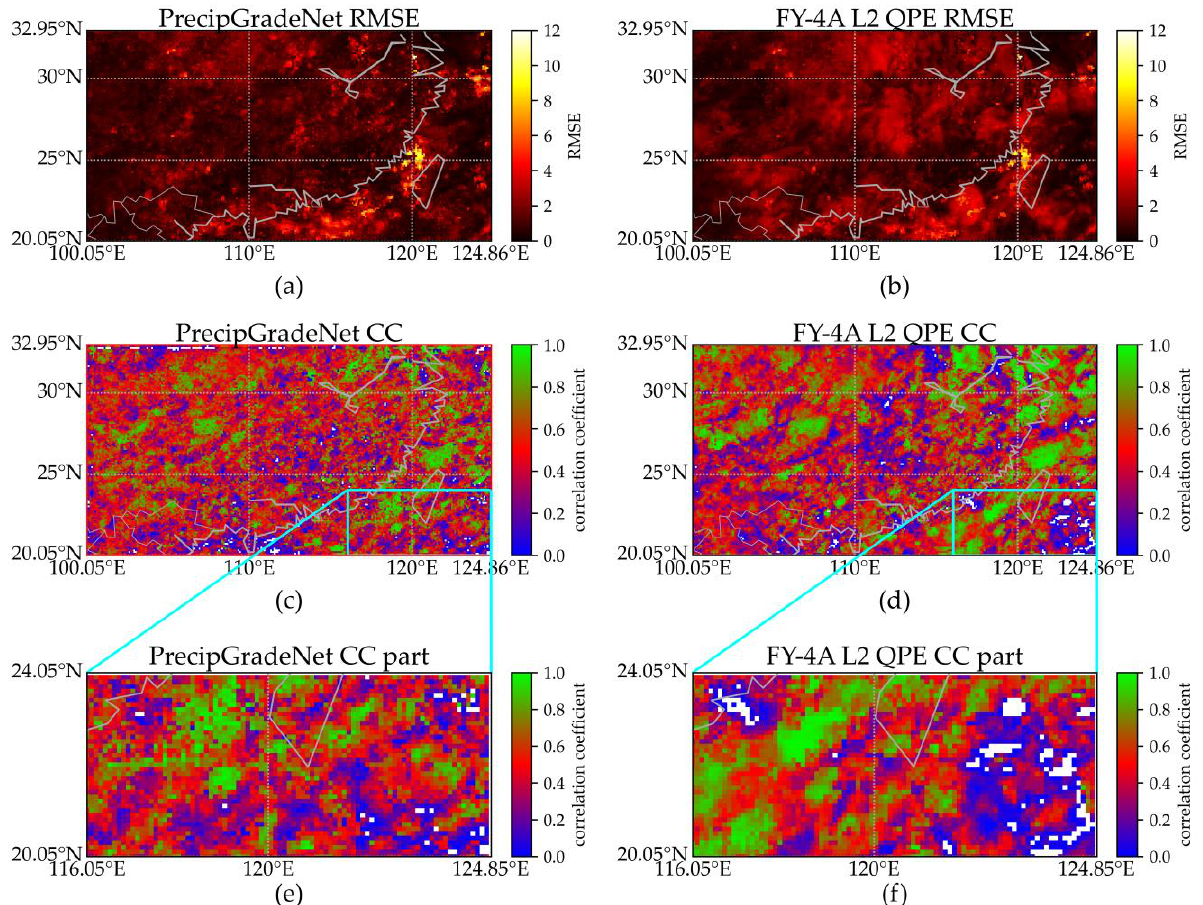
Figure 7. The Root Mean Square Error (RMSE) and Pearson correlation coefficient (CC) map for the FY-4A L2 QPE and PrecipGradeNet during the test period (from 4 August 2021 to 7 October 2021). ( a ) RMSE between the prediction of PrecipGradeNet and IMERG. ( b ) RMSE between the FY-4A L2 QPE and IMERG. ( c ) CC between the prediction of PrecipGradeNet and IMERG. ( d ) CC between the FY-4A L2 QPE and IMERG ( e ) part of ( c ) at 20°N – 24°N, 106°E – 125°E. ( f ) part of ( d ) at 20°N – 24°N, 106°E – 125°E.